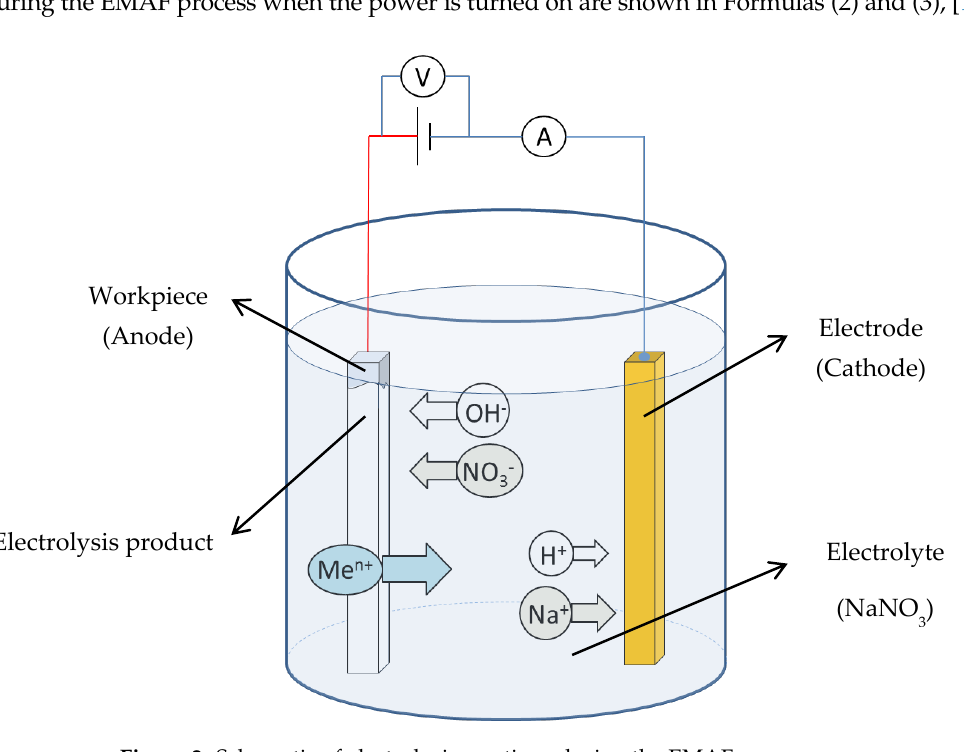
Figure 2. Schematic of electrolysis reactions during the EMAF process.